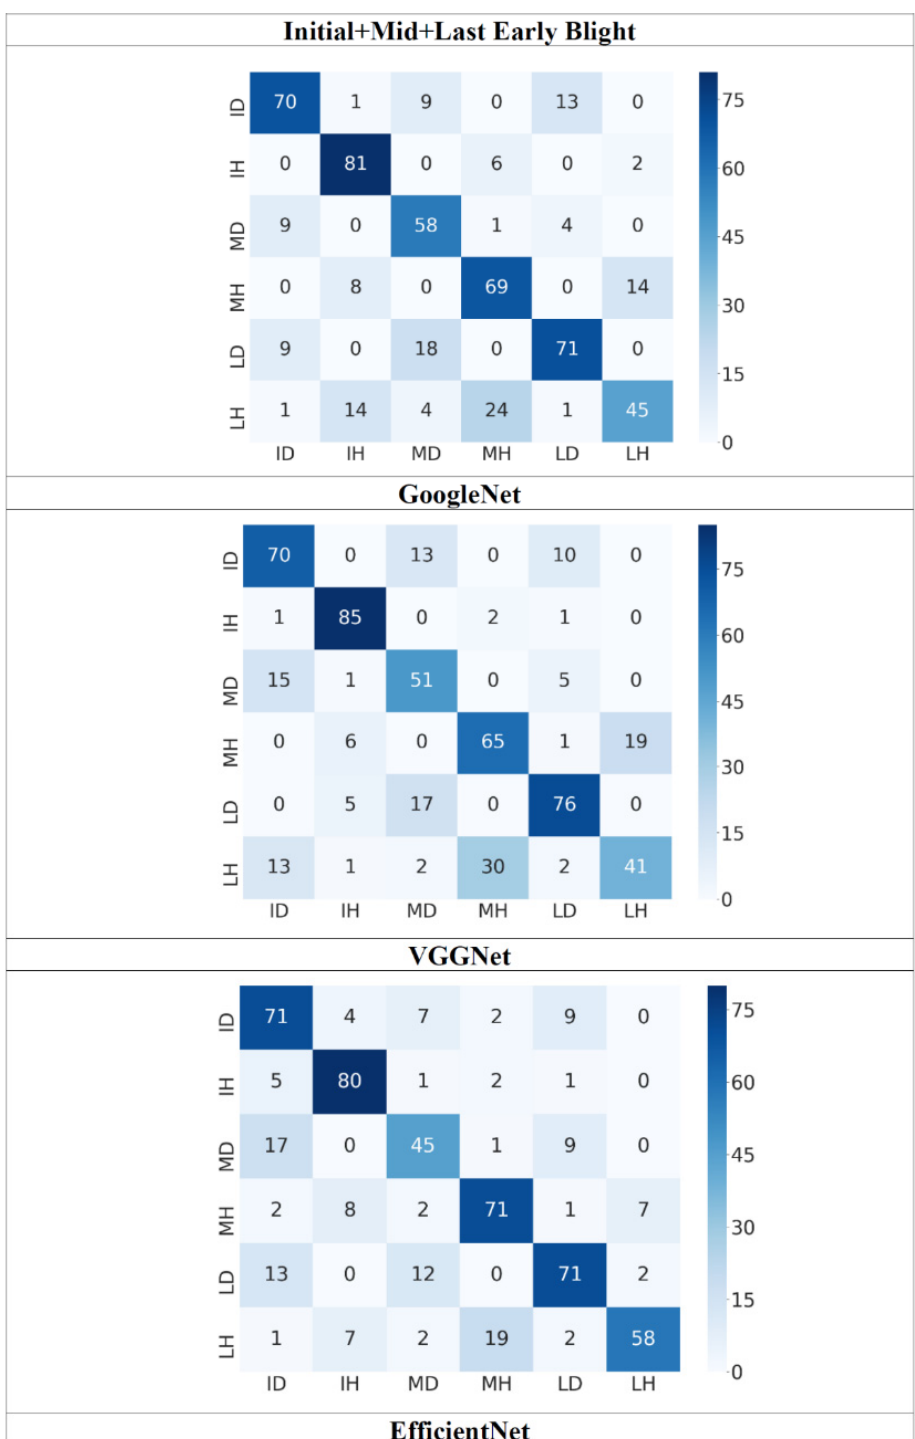
Figure 5. Confusion matrices of 6-Class convolutional neural networks, where IH = number of actual and predicted initial healthy plants; ID = number of actual and predicted initial diseased plants; MH = number of actual predicted mid healthy plants; MD = number of actual and predicted mid diseased plants; LH = number of actual and predicted healthy plants; LD = number of actual and diseased